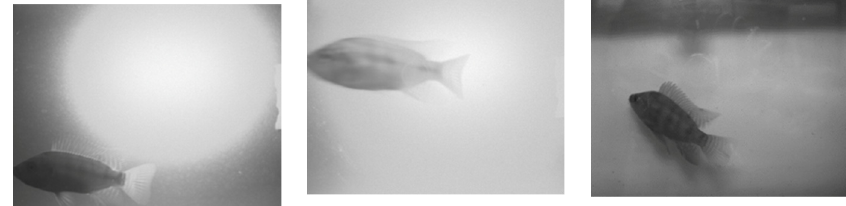
Figure 10. Captures from NIR camera.